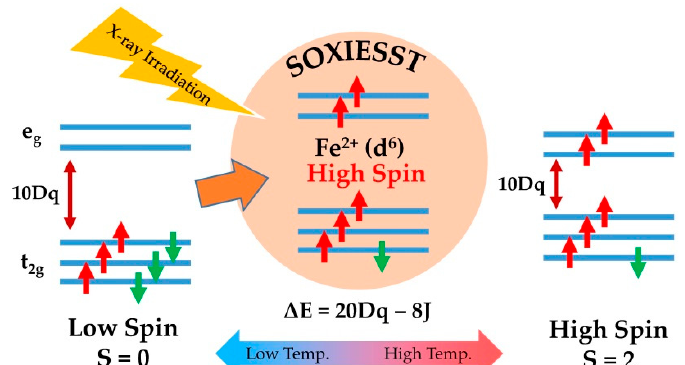
Figure 1. Illustration of the Fe 2+ ( d 6 ) d orbital energy splitting under octahedral ligand field and the resultant LS (low spin) and HS (high spin) configurations. The SCO (spin crossover) from LS to HS with increasing temperature can be explained by the weakened ligand field, i.e. lower 10 Dq. If a soft X-ray–induced excited spin state trapping (SOXIESST) effect is activated, HS configuration is persistent even at temperatures below T C .